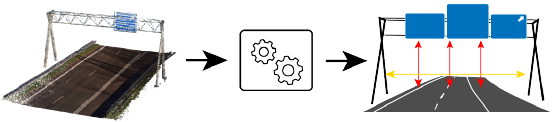
Figure 2. A simplification of the tool to be developed in this research. A point cloud of a gantry is taken as input and processed. The result is a visualization with the estimated